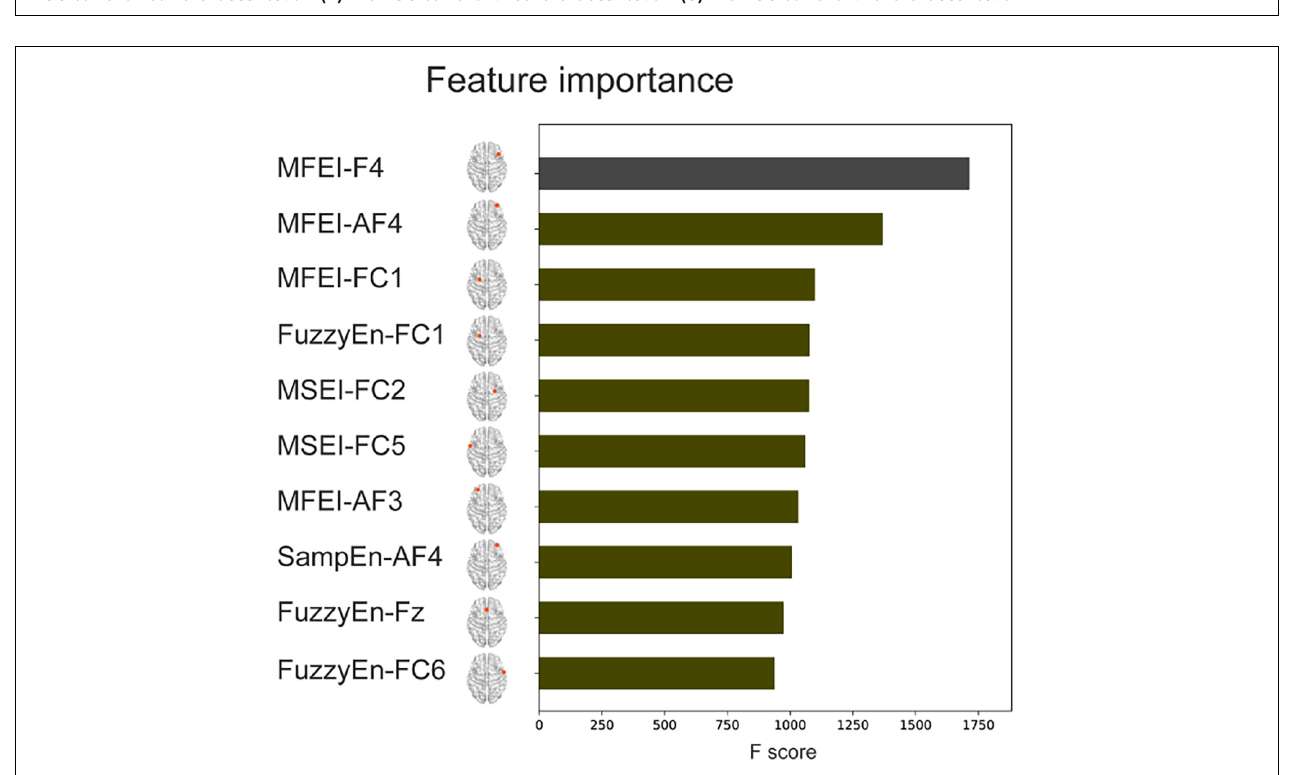
FIGURE 6 | The Receiver Operating Characteristic (ROC) curves of Complexity-XGBoost and Classical-XGBoost methods for three classification strategies. (A) The ROC curve for four-level classification. (B) The ROC curve for three-level classification. (C) The ROC curve for two-level classification.